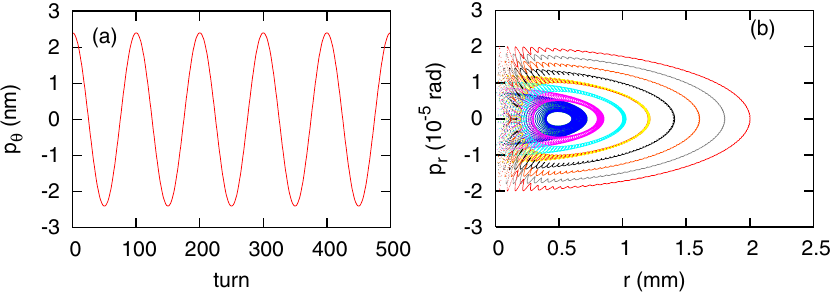
(cid:5) 0 : 285 and (cid:8) x